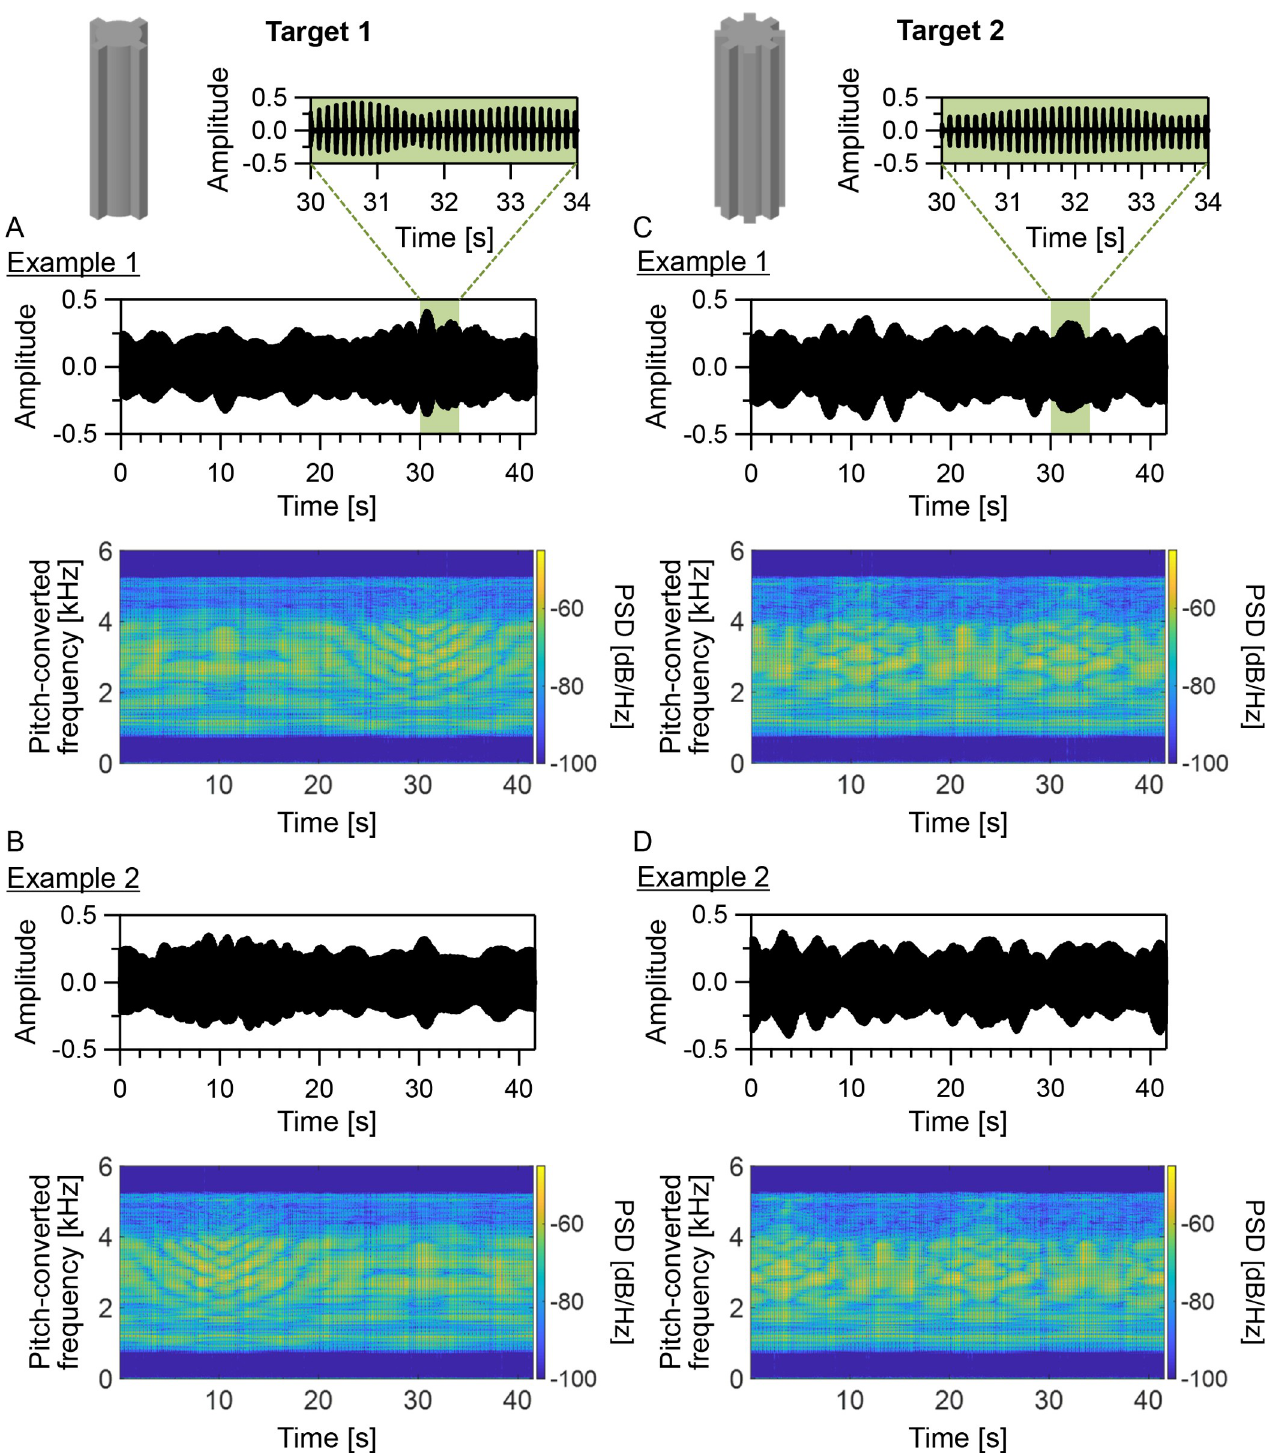
Fig 6. Time-varying echoes from rotating targets. (A–D) are examples of amplitude waveforms (top) and spectrograms (bottom) of the pitch-converted binaural sounds to which P12 listened for 41.6 s (5.2 s [signal duration] × 8 [inverse number of the pitch-conversion rate]) in the test trials under the rotating condition. The pitch-converted binaural sounds include the pitch-converted binaural echoes from rotating targets 1 (A and B) and 2 (C and D). The figure also provides examples of enlarged amplitude waveforms (at a timing of 30–34 s; A and C). The spectrograms were calculated using fast Fourier transform (FFT). The sampling frequency was 12 kHz, and the FFT window length was 2,048